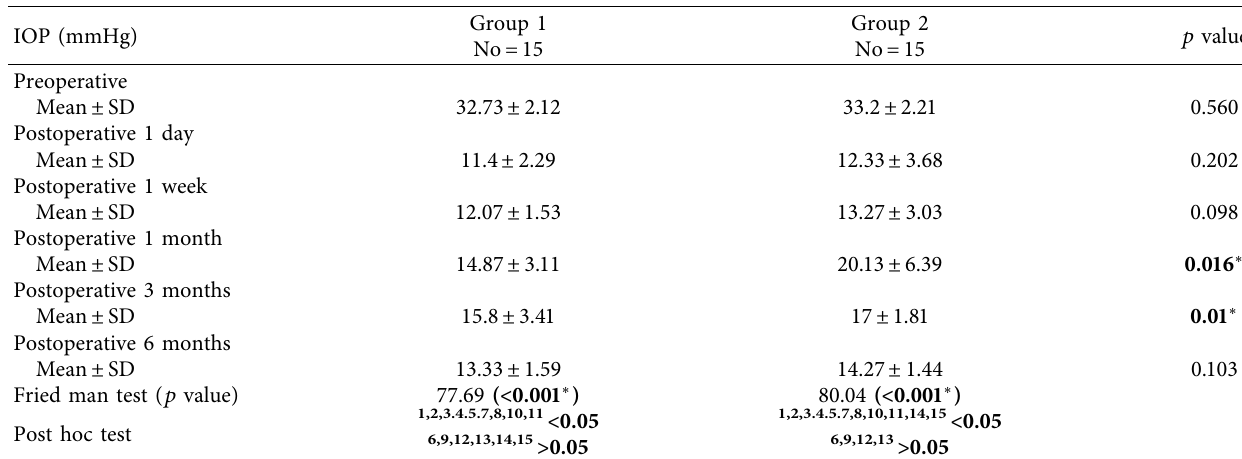
Table 2: IOP of the studied